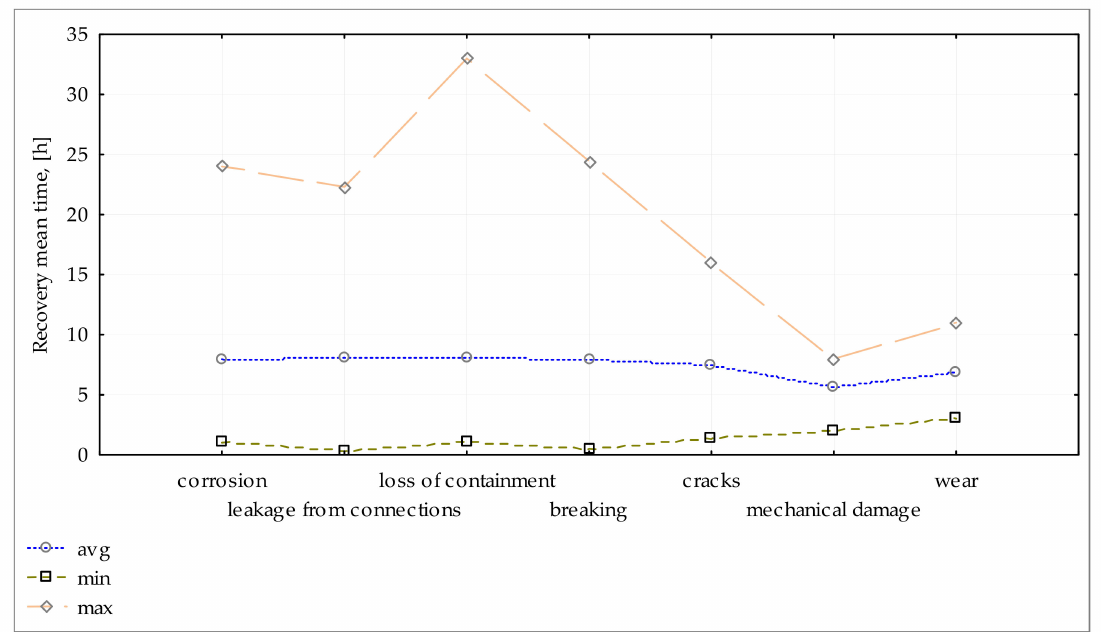
Figure 8. Failure removal time regarding failure mode of water